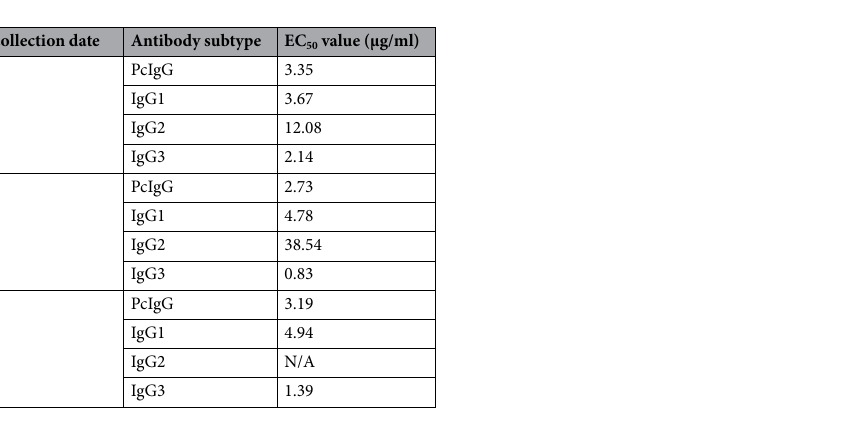
Table 1. Estimated EC 50 values for purified Alp-PcIgG and IgG subtypes from alpaca 1 plasma collections.